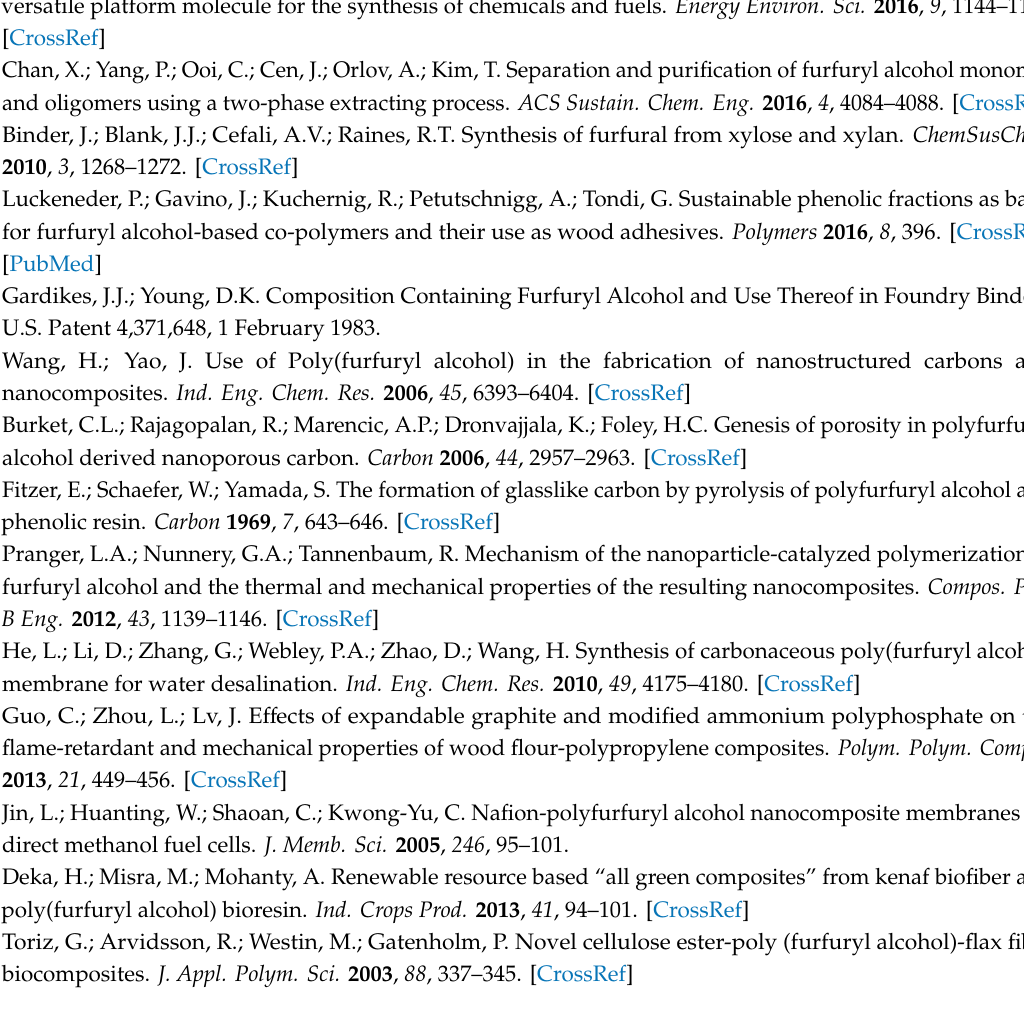
Figure S1: Extruded filaments of a 50 / 50 blend having di ff erent diameters, Figure S2: Optical view of CHO cells at the end of the indirect toxicity